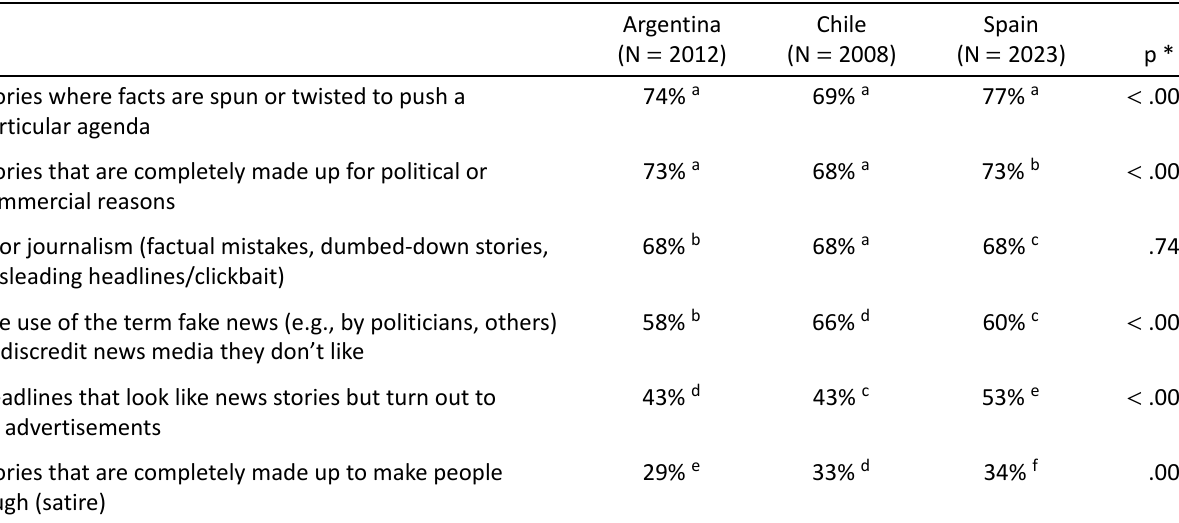
Table 2. Concern about disinformation by